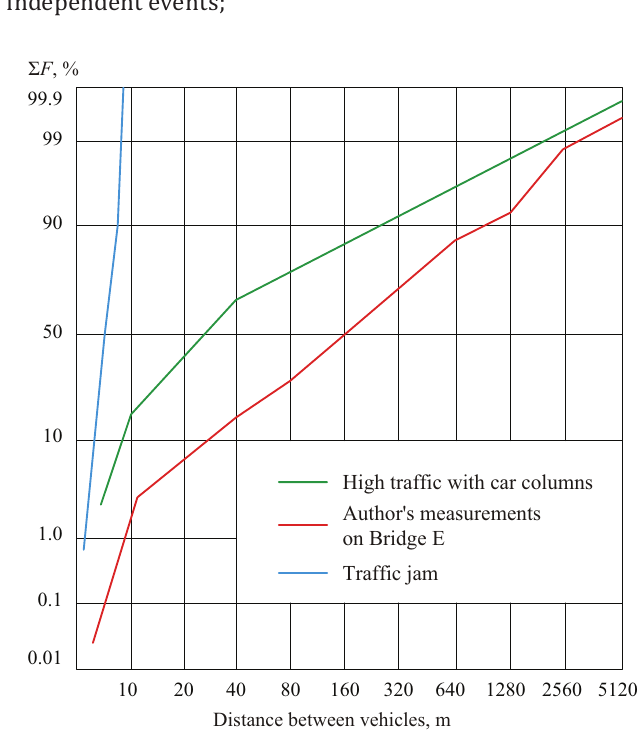
Figure 7. Distribution functions of the distance between vehicles according to measurements, at a daily traffic volume of N Vd = 2976 (red line). The green line refers to vehicle traffic in columns. The blue line denotes traffic